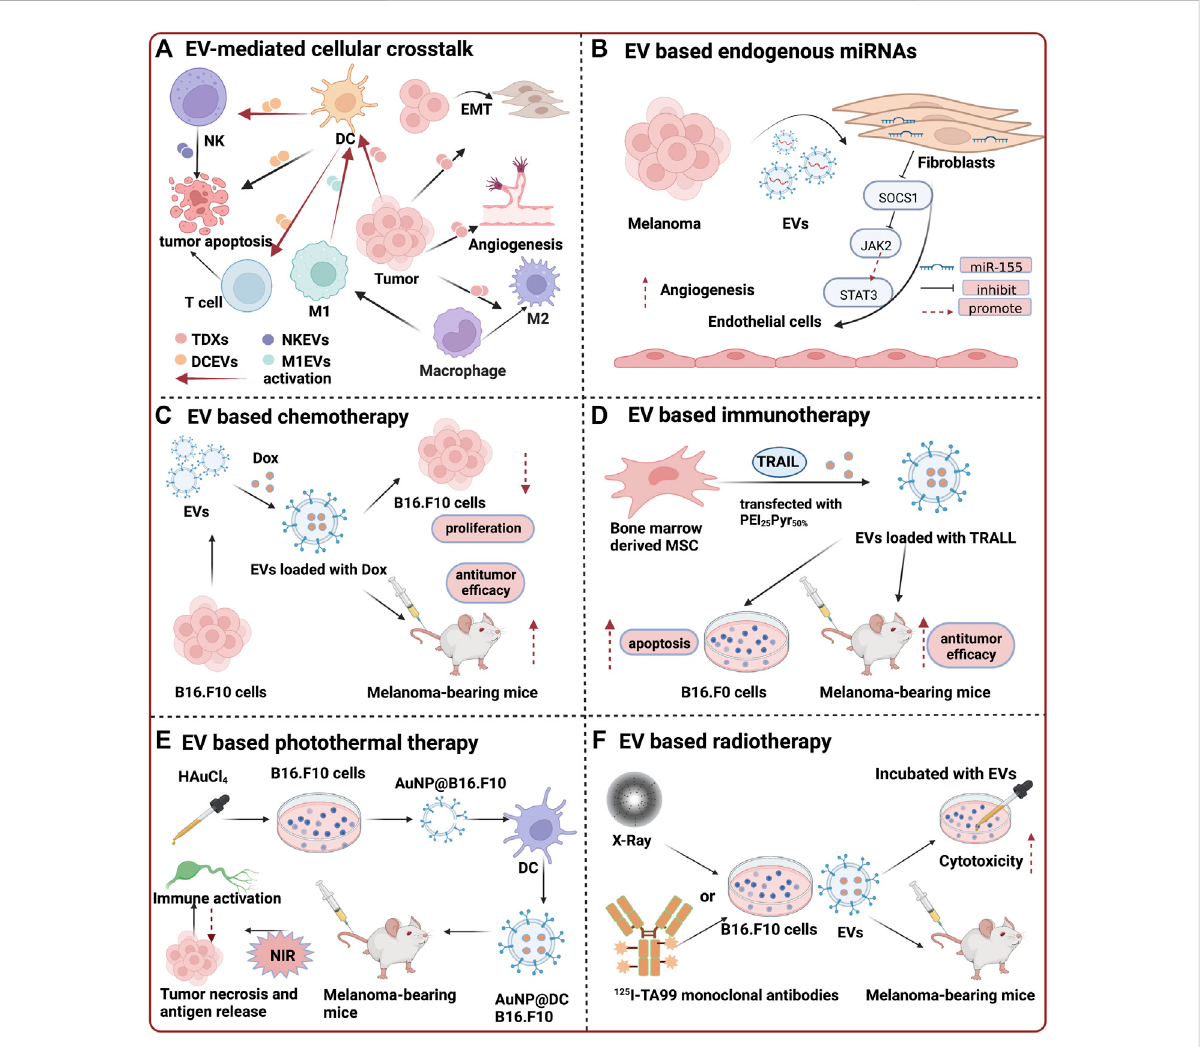
FIGURE 1 Summary of extracelluar vesicle assisted therapy for melanoma. (A) EV-mediated cellular crosstalk within the tumor microenvironment; (B) EV based endogenous miRNAs for melanoma treatment. MiR-155 within exosomes can induce the proangiogenic switch of cancer-associated fi broblasts by promoting the expression of proangiogenic factors via SOCS1/JAK2/STAT3 signaling pathway. (Zhou et al., 2018).Reproduced with permission. Copyright 2018, BioMed Central. (C) EV based chemotherapy. DOX that are loaded inside EVs exerted much higher inhibitory effects on the proliferation of B16.F10 melanoma cells. (Patras et al., 2022). Reproduced with permission. Copyright 2021, Taylor & Francis Group, LLC. (D) EV based immunotherapy. Bone marrow-derived MSCs transfected with plasmid encoding TRAIL indicated signi fi cant cell death compared to non-treated B16F0 cells. The tumor volume was also signi fi cantly reduced in vivo . (Shamili et al., 2018).Reproduced with permission. Copyright 2018, ELSEVIER. (E) EV based photothermal therapy. With near infrared (NIR) laser irradiation, AuNP@DCB16.F10 at tumor site generated hyperthermia, resulting in the apoptosis and necrosis of primary tumor and release of tumor antigens. Upon activation, mature DCs presented antigens to T cells and trigger the subsequent antitumor immune response. (Zhang et al., 2019a).Reproduced with permission. Copyright 2019, AmericanChemical Society. (F) EVbasedradiotherapy.EVsisolatedfromconditioned mediumofAuger-RIT exposedcellsareassociated withabout 30 – 40% bystander cytotoxic effects. (Karam et al., 2021).Reproduced with permission. Copyright 2021, Taylor & Francis Group,